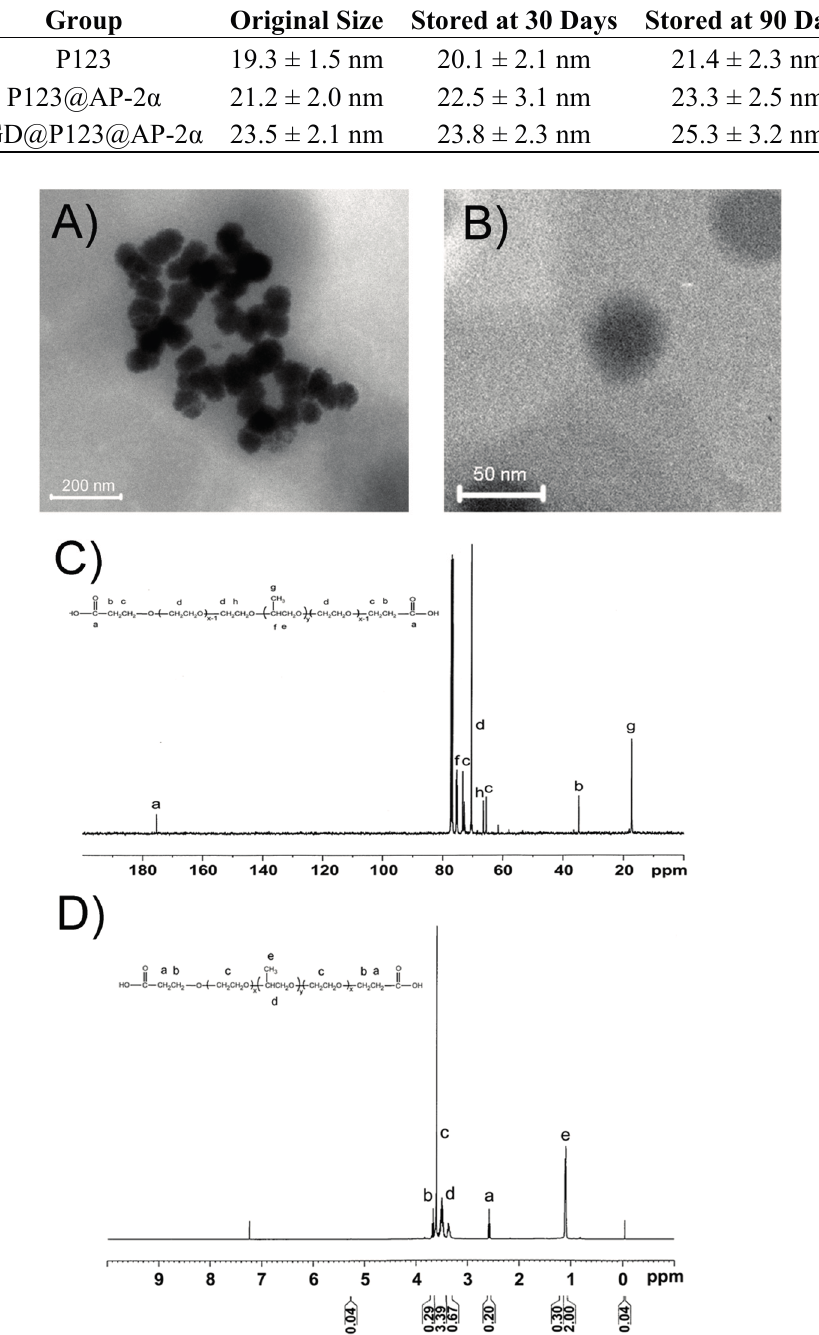
Figure 1. ( A ) Transmission electron microscopy (TEM) and ( B ) High resolution